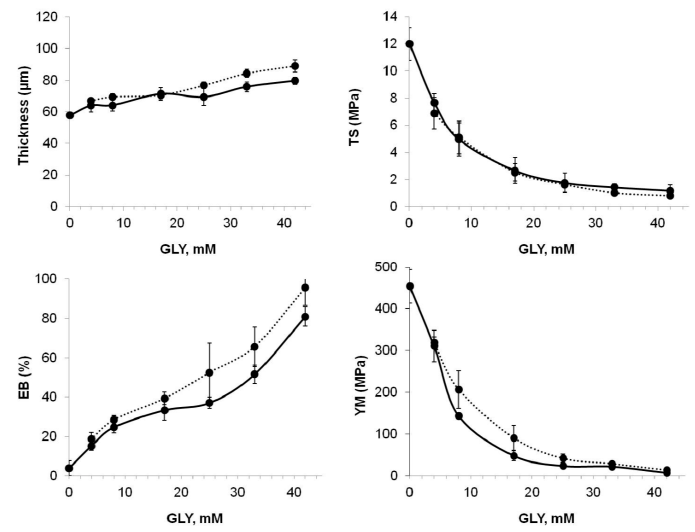
Figure 2. Effect of different GLY concentrations on the mechanical properties of films prepared by BV proteins treated at 80 °C, in the presence of 3 mM SPD at either pH 8.0 (solid line) or pH 11.0 (dotted line). Brittle and unhandleable films were obtained by casting FFSs prepared in the absence of GLY at pH 11.0. The results are expressed as mean ± standard deviation. Further experimental details are given in the text.